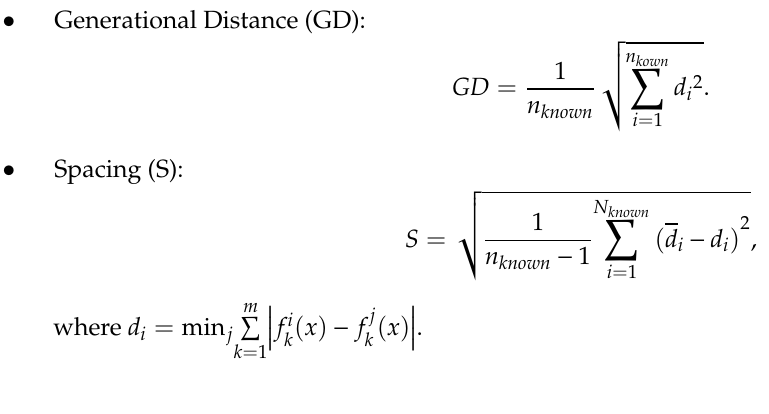
Table A2. Parameters of the algorithms for the benchmark